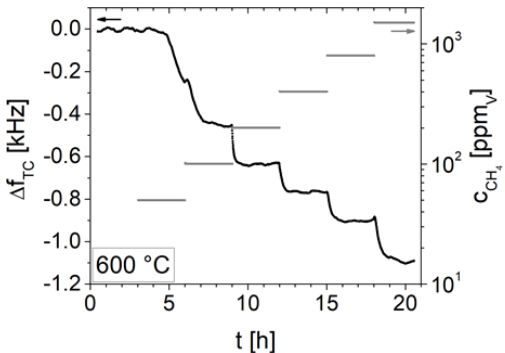
Figure 15. Temperature-compensated resonance frequency shift in a 5MHz resonator coated with a SnO 2 electrode and corresponding change in methane concentration over time.